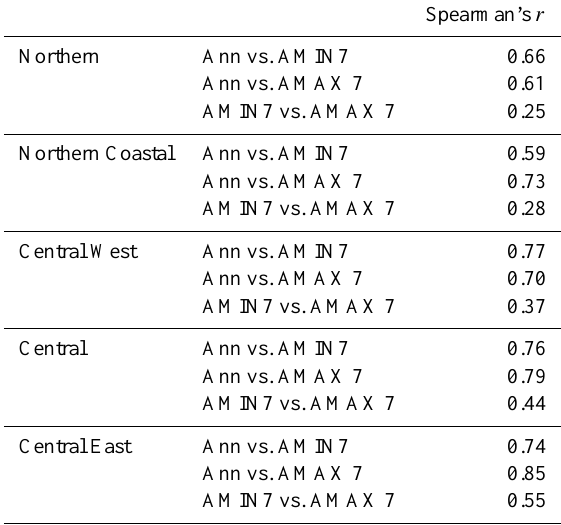
Table 2. Spearman’s rank correlation coefficient between the annual (Ann), high flow (AMAX7) and low flow (AMIN7) RA STD series (all values are significant at p < 0.05 for a two-tailed test, where the critical threshold is r > 0.236).